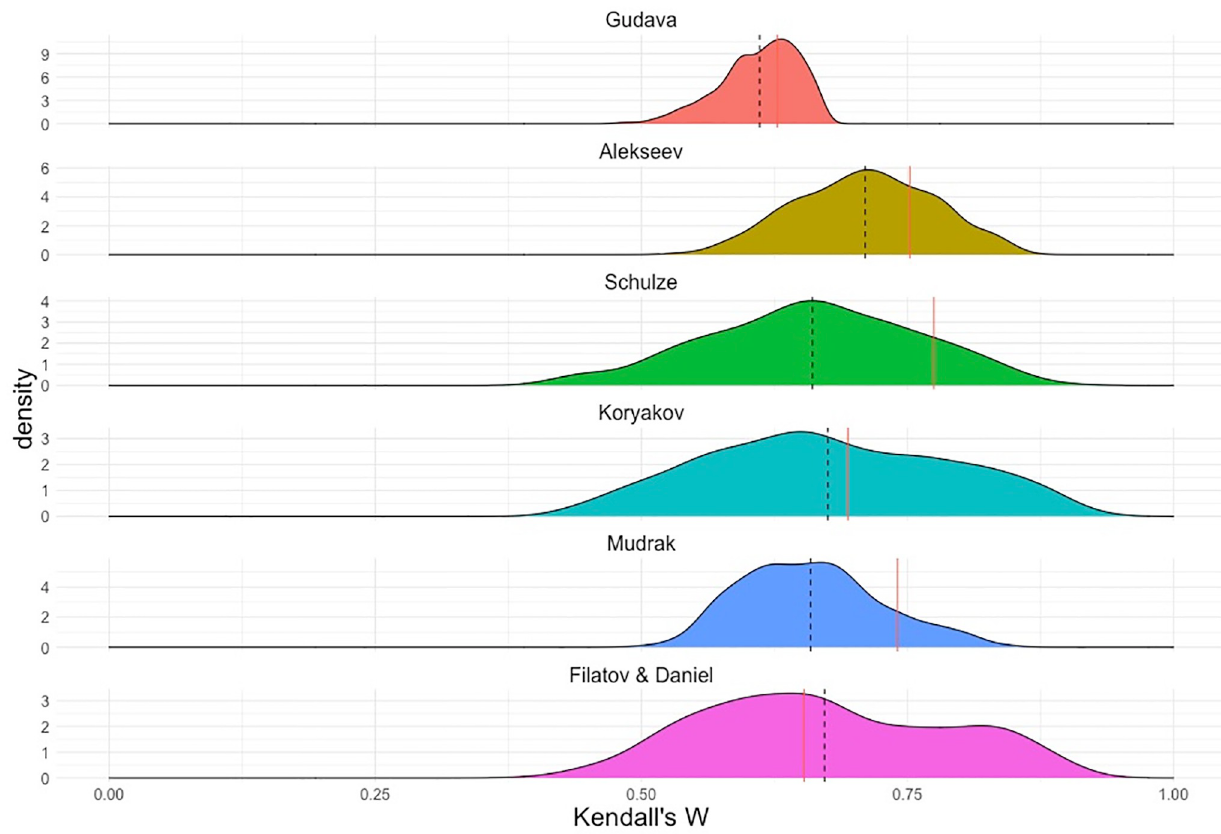
Fig 8. Distributions of Kendall’s W for re-sampled village sets (1,000 permutations). Dashed lines represent the mean of the distribution, andfull red lines represent the observed value for the phylogeny, as red bars in Fig 6.